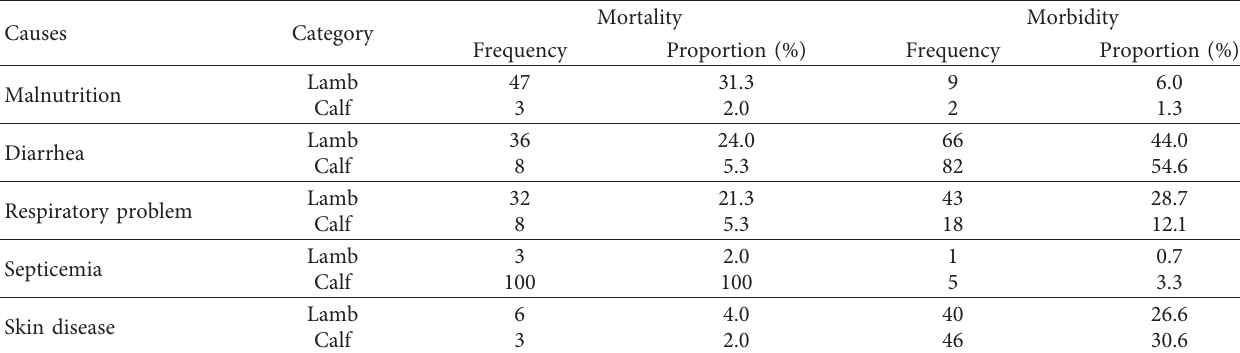
Table 3: Causes of lamb and calf morbidity and mortality in the mixed livestock-crop production system.